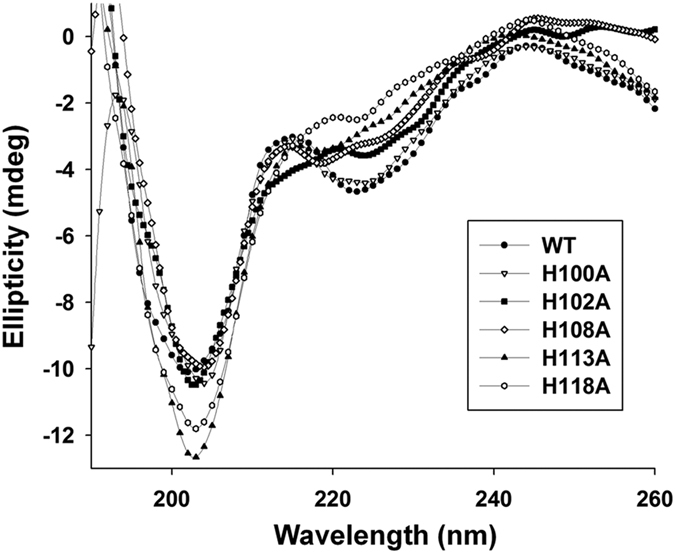
Far-ultra violet (UV) circular dichroism (CD) analysis of the differences between histidine mutant and WT proteins.Far-UV CD spectra (190–260 nm) of H100A, H102A, H108A, H113A, H118A and WT proteins were obtained in 25 mM sodium phosphate buffer, pH 7.4, with 1 mm path length of the quartz cuvette at 4 °C. The data collection bandwidth was set to 1 nm. The changes in ellipticity values at 200–210 nm and 220–225 nm range were monitored indicated different secondary structures of histidine mutants and WT in solution. Further secondary structure variations in percentages for each histidine mutant and WT determined using the CDSSTR program are presented in Supplementary Table SII. Data are representative of three independent experiments were subjected to smoothing.